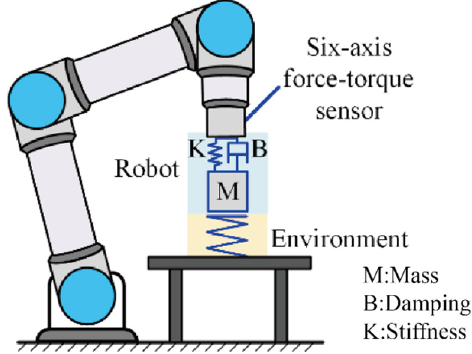
Figure 1. Contact force model for estimation.